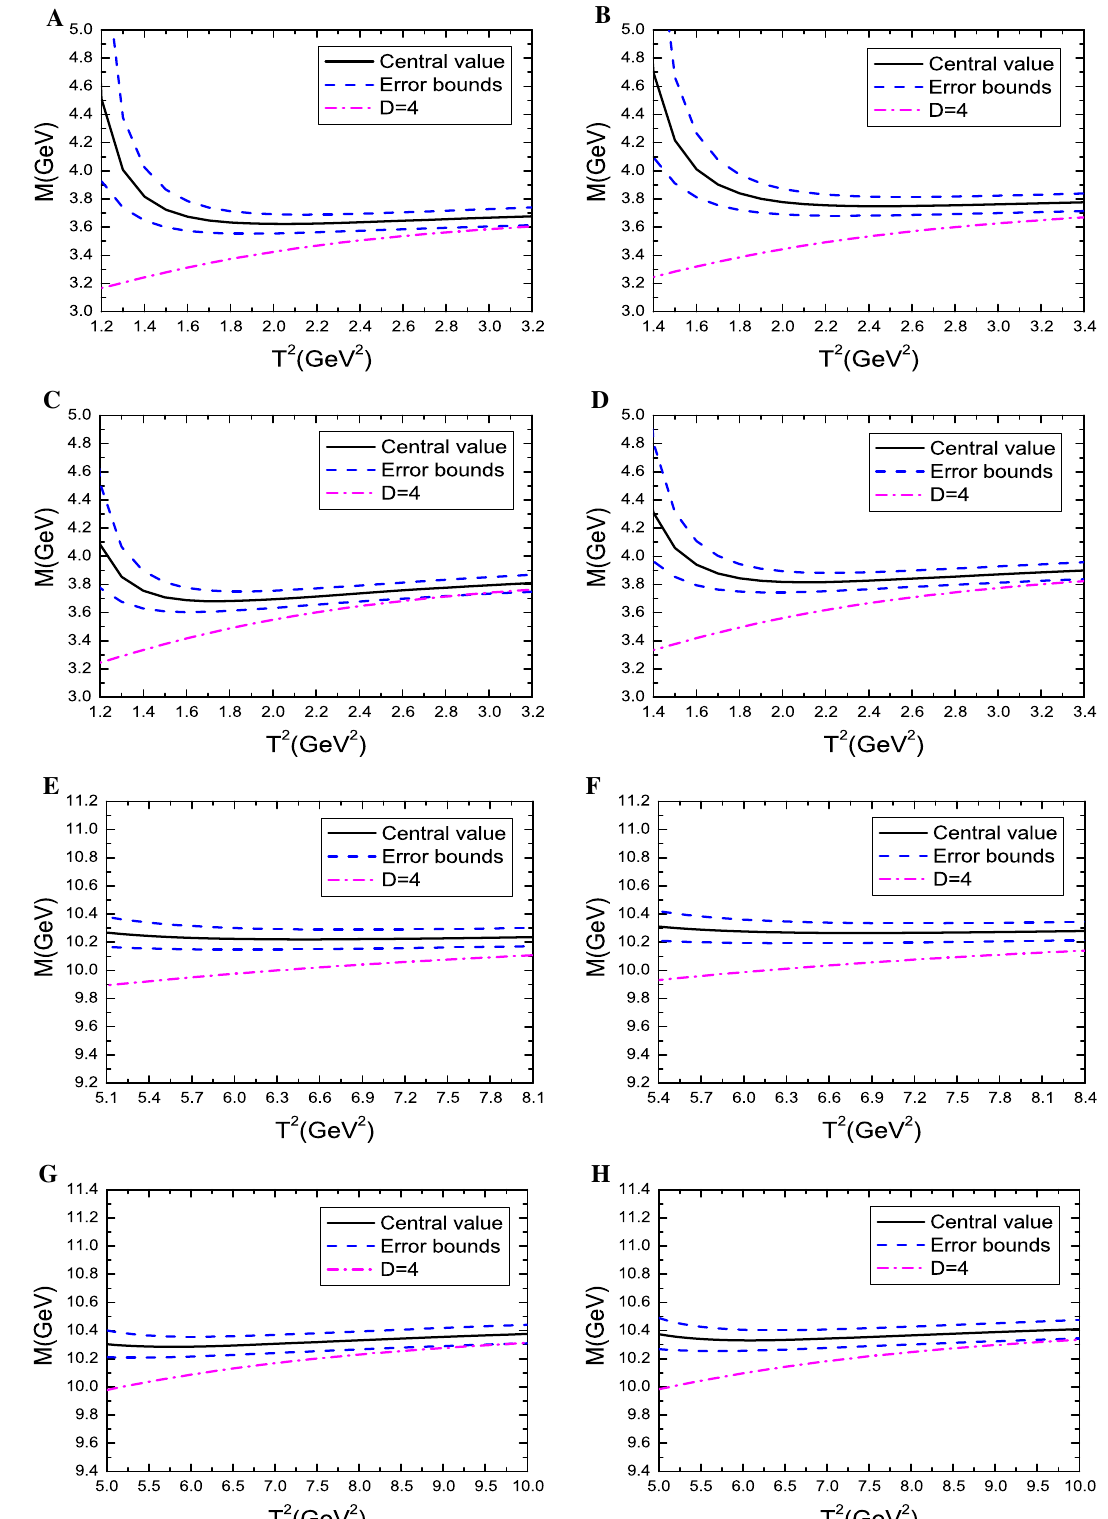
Fig. 4 The masses of the doubly heavy baryon states with variations of denotes the predictions based on the truncations of the operator product the Borel parameters T 2 , where the A , B , C , D , E , F , G and H denote expansion up to the vacuum condensates of dimension the (cid:2) cc , (cid:2) ∗ cc , (cid:10) cc , (cid:10) ∗ cc , (cid:2) bb , (cid:2) ∗ , (cid:10) bb and (cid:10) ∗ , respectively, the D = 4 bb bb